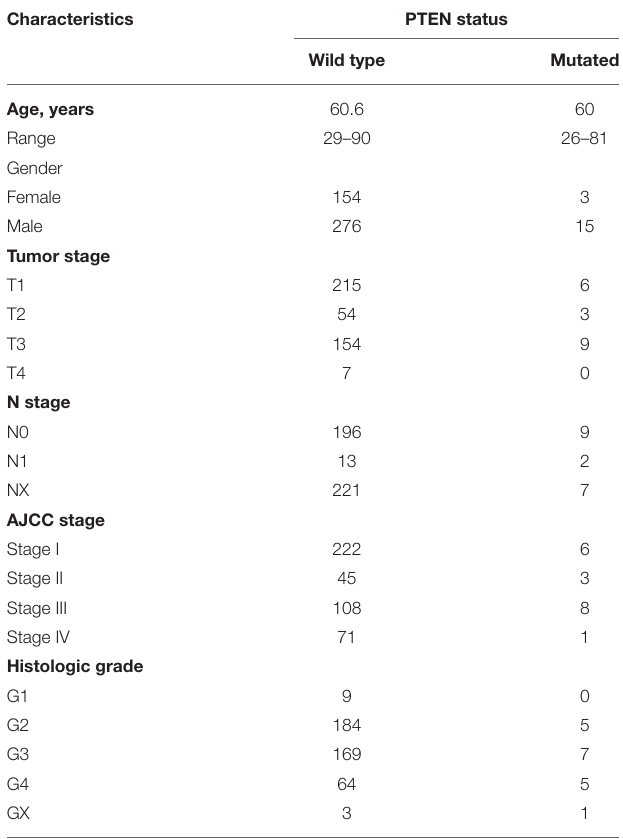
TABLE 1 | Clinical characteristics of ccRCC patients and PTEN status in